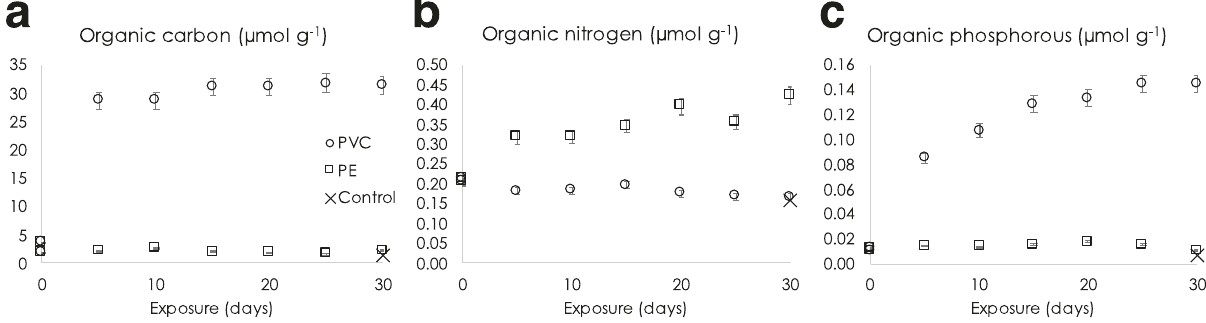
Fig. 3 Organic carbon, nitrogen, and phosphorous in seawater. Dissolved organic carbon (DOC, a ), phosphorous (DOP, b ), and nitrogen (DON, c ) released into seawater per gram of polyvinylchloride (PVC) or polyethylene (PE) over time during the course of the experiment under biotic conditions at atmospheric pressure 0.1 MPa. Controls consist of seawater incubated with no polymer pellets for 30 days under biotic conditions. The diameter of the PVC and PE pellets is in the 3 – 5 mm range. Error bars show standard deviation ( n =